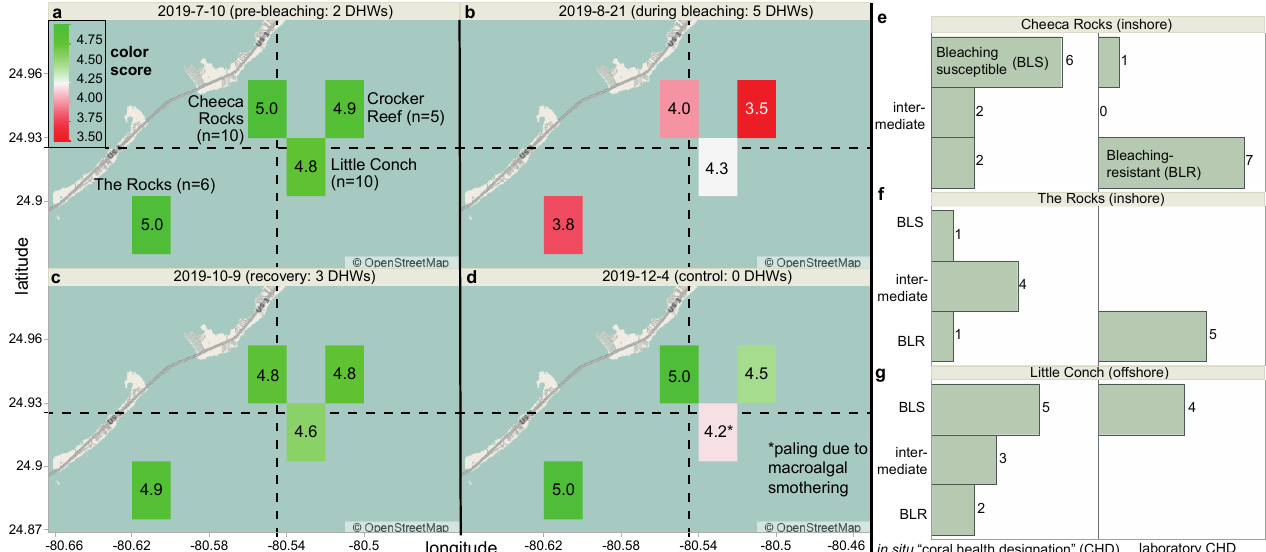
Figure 1. Map of study sites ( a – d ) and breakdown of field-tracked and lab coral phenotypes ( e – g ). Field sample sizes and the color score legend are both in a. DHW = degree-heating weeks. Panels e, f, and g present the breakdown of samples from three of the four study reefs (excluding the test site, Crocker Reef) with respect to their bleaching susceptibility, and the values adjacent to the columns signify number of colonies (rather than genotypes) since, in certain cases, colonies of the same genotype demonstrated different thermotolerances. The colony health designations (CHD) of lab corals [11] from these same reefs have also been shown. Note that the five field-tracked colonies from Crocker Reef, which did not feature in the experiments, were characterized by the following CHD: bleaching-resistant (n = 1), intermediate (n = 2), unknown (n = 1; unable to locate colony at all survey times), and diseased (n = 1; succumbed to stony coral tissue loss disease & was excluded from analysis).